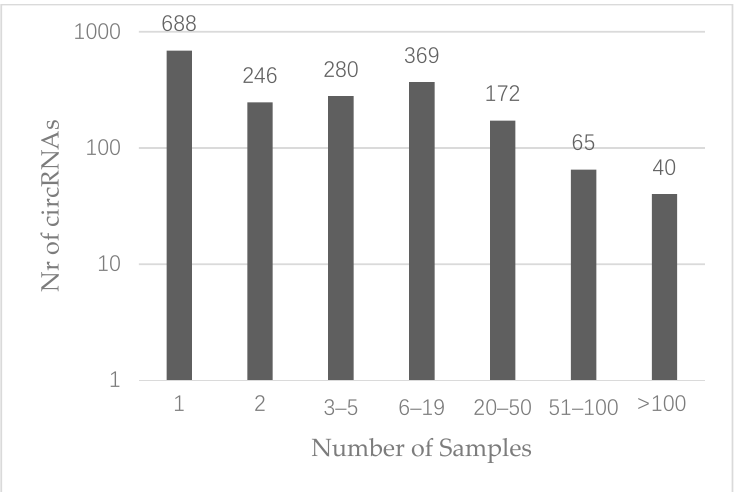
Figure 1. Histogram showing the distribution of circRNA occurrence in the 181 stage I/II colon cancer samples. A total of 1860 distinct circRNAs were identified which were derived from known genes. Table 2. Most frequently recurring circRNAs. Circular